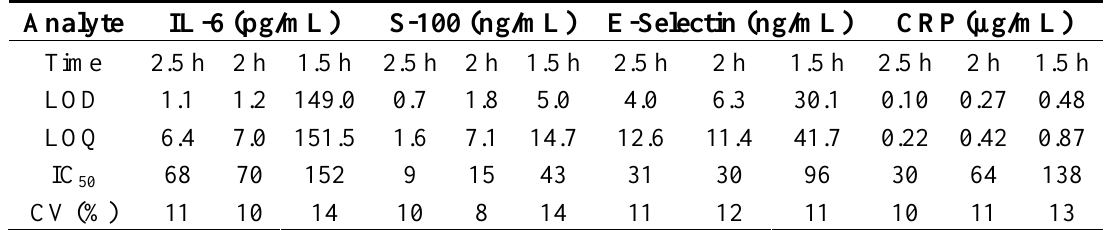
Table 2. Assay parameters for IL-6, S-100, E-Selectin and CRP obtained after 2.5 h, 2 h and 1.5 h